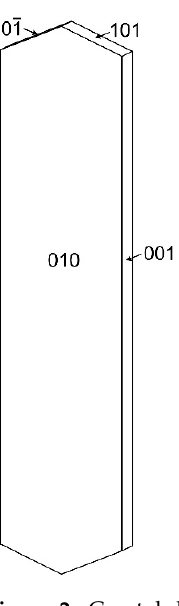
Figure 2. Crystal drawing of chenowethite; clinographic projection in non-standard orientation, [100] vertical.